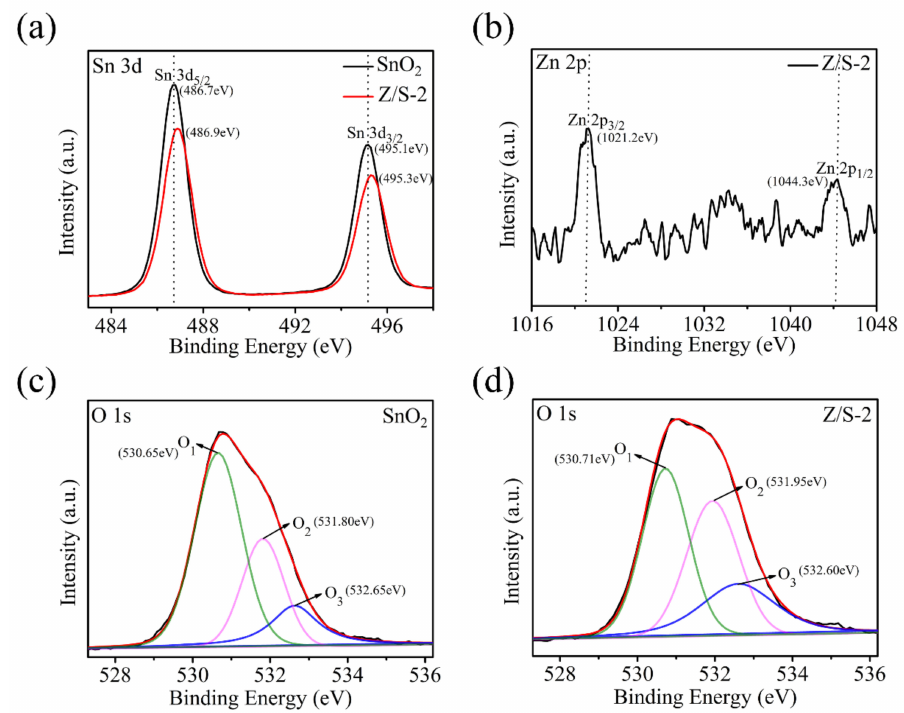
Figure 6. XPS spectra of ( a ) Sn 3d spectra of SnO 2 and Z/S-2 composite, ( b ) Zn 2p spectrum of Z/S-2 composite, ( c , d ) O 1s spectra of SnO 2 and Z/S-2